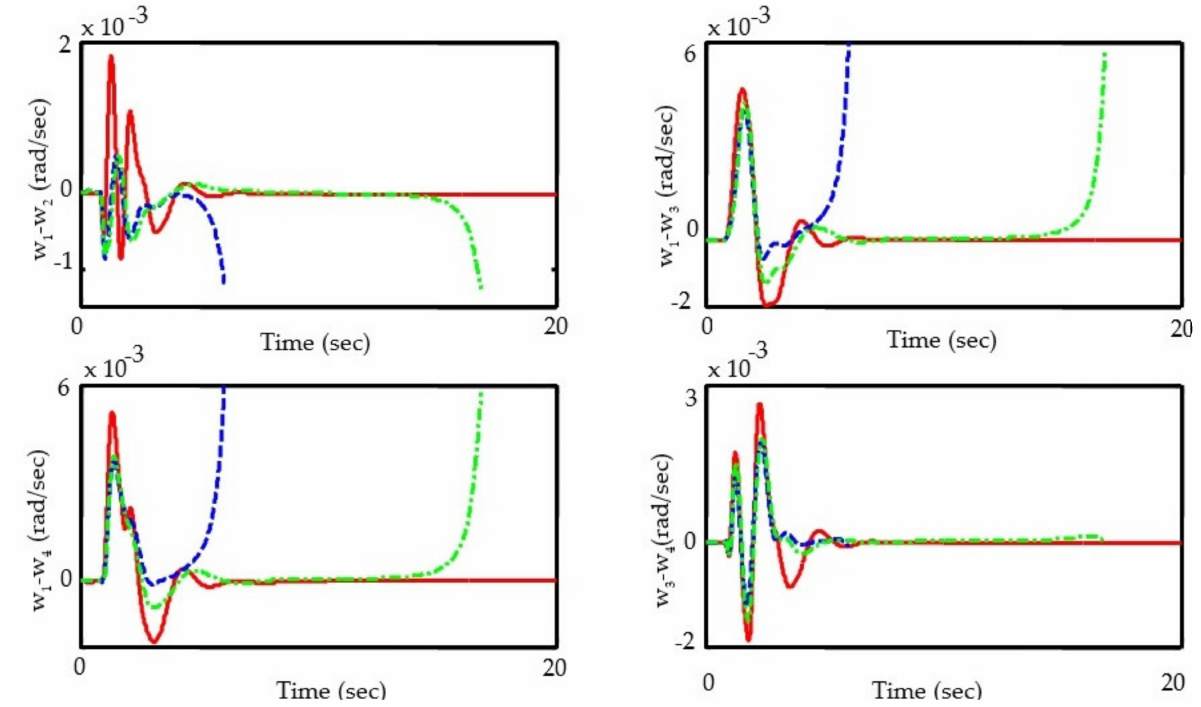
Figure 12. Angular velocity deviation the second scenario for the heavy load; proposed (red line), BFA (blue dashed line), GA (green dash–dotted line).